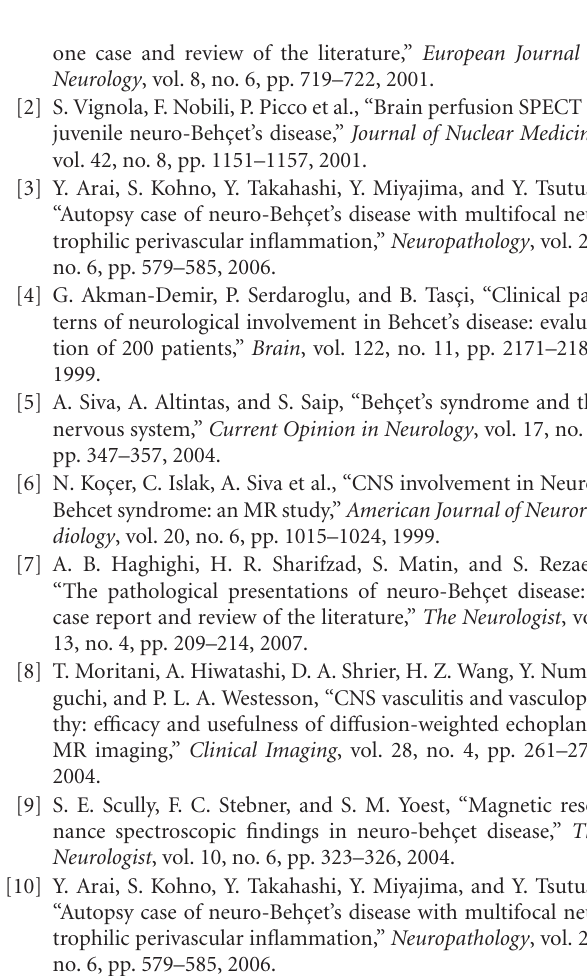
Kao et al. found hypoperfusion in gray matter in all cases of 13 patients with NBD in SPECT study [27].